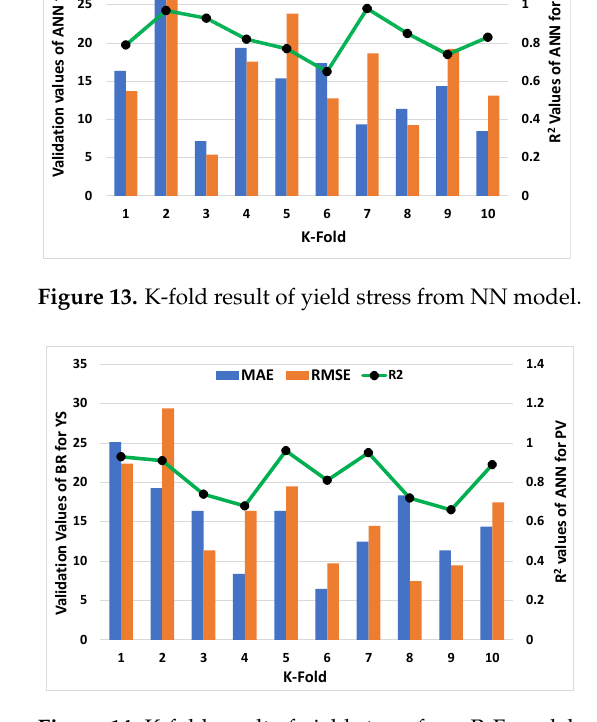
Figure 14. K-fold result of yield stress from R-F model.